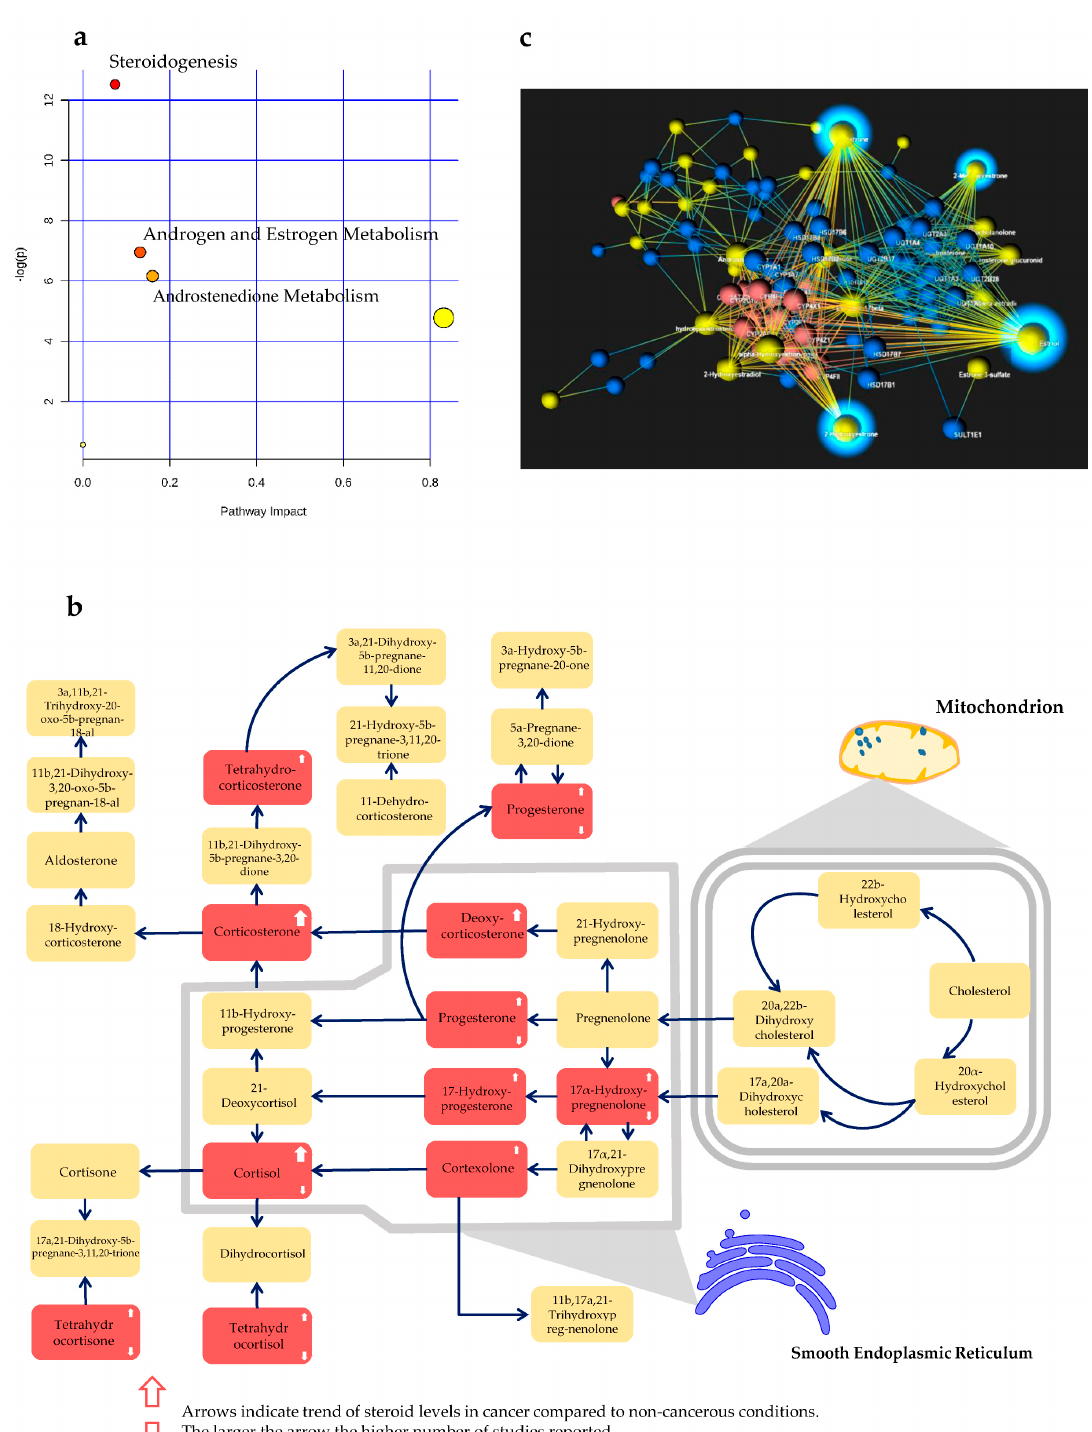
Figure 3. Associated biological processes of the steroid biomarkers reported in at least two studies. ( a ) Three significantly enriched pathway of the included steroids, ( b ) steroidogenesis pathway visualization and the altered steroids, the red boxes refer to the potentially altered steroids in the included studies, and ( c ) the network visualization of the steroids reported in at least two studies. Sparkling nodes indicate the central molecules in our network